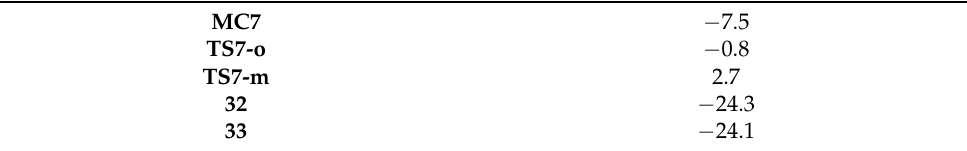
Table 3. ω B97XD/6-311G(d,p) relative electronic energies in acetonitrile, kcal · mol − 1 , of the stationary points involved in the I-DA reaction of iminium cation 6 with CpMe 20